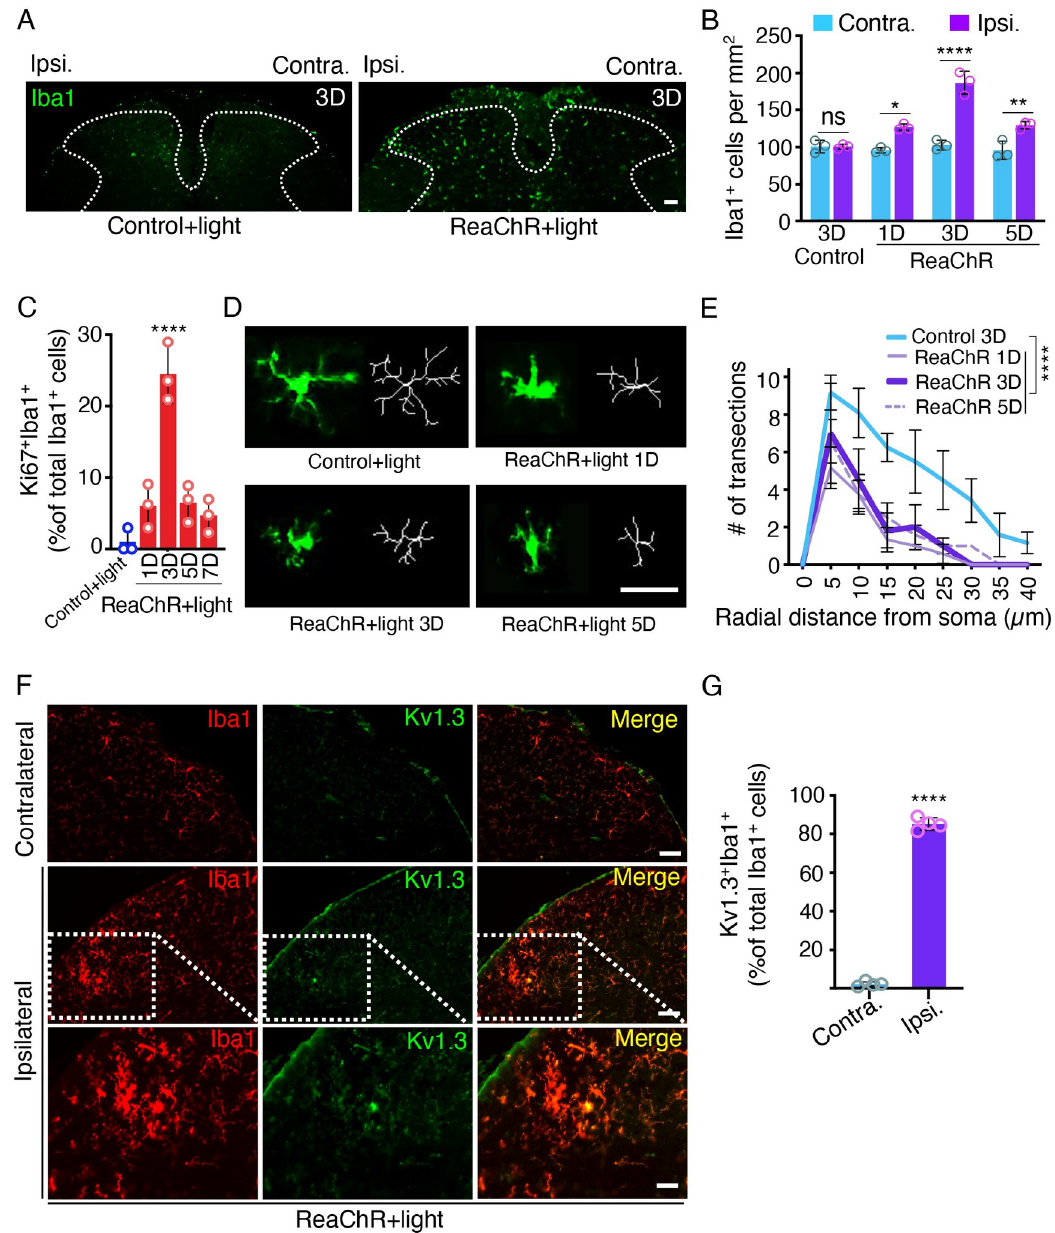
Fig 4. Optogenetic stimulation induces microglia activation. (A) Representative images of Iba1 + microglia after light stimulation in control mice (left) and ReaChR mice (right). Scale bar, 40 μ m. (B) Summarized data showing that the number of Iba1 + microglia was increased in the ipsilateral dorsal horn at 1–5 days after light stimulation in ReaChR mice as compared to the contralateral side and control group. n = 3 mice/group. ns. P > 0.9999, � P = 0.0476, �� P = 0.0049, ���� P < 0.0001 for Contra. vs. Ipsi. Two-way ANOVA with multiple comparisons. (C) A quantitative summary showing the percentage of colabelled Ki67 + and Iba1 + cells of the total Iba1 + cells were significantly increased at 3 days after optogenetic stimulation compared to control group. Data are presented as mean ± SEM. n = 3 mice/group, ���� P < 0.0001. One-way ANOVA. (D) Representative single microglia images in the spinal cord using Iba1 immunostaining and after being skeletonized following optogenetic stimulation. Scale bar, 40 μ m. (E) Sholl analysis indicates that optogenetic stimulation reduced the complexity of ReaChR microglia compared with the control group. n = 5 mice/ group, ���� P < 0.0001. Two-way ANOVA. (F) Representative immunostaining images showing the increased expression of Kv1.3 (green) in Iba1 + (red) microglia at 3 days after light stimulation in the ipsilateral dorsal horn compared with the contralateral side without light stimulation in ReaChR mice. (G) Summarized data showing the co-localization of Kv1.3 with Iba1 + cells. Data are presented as mean ± SEM, n = 4 mice/group, ���� P < 0.0001, unpaired Student t test. Scale bar, 40 μ m. For data plotted in graphs, see S1 Data. ReaChR, red-activated